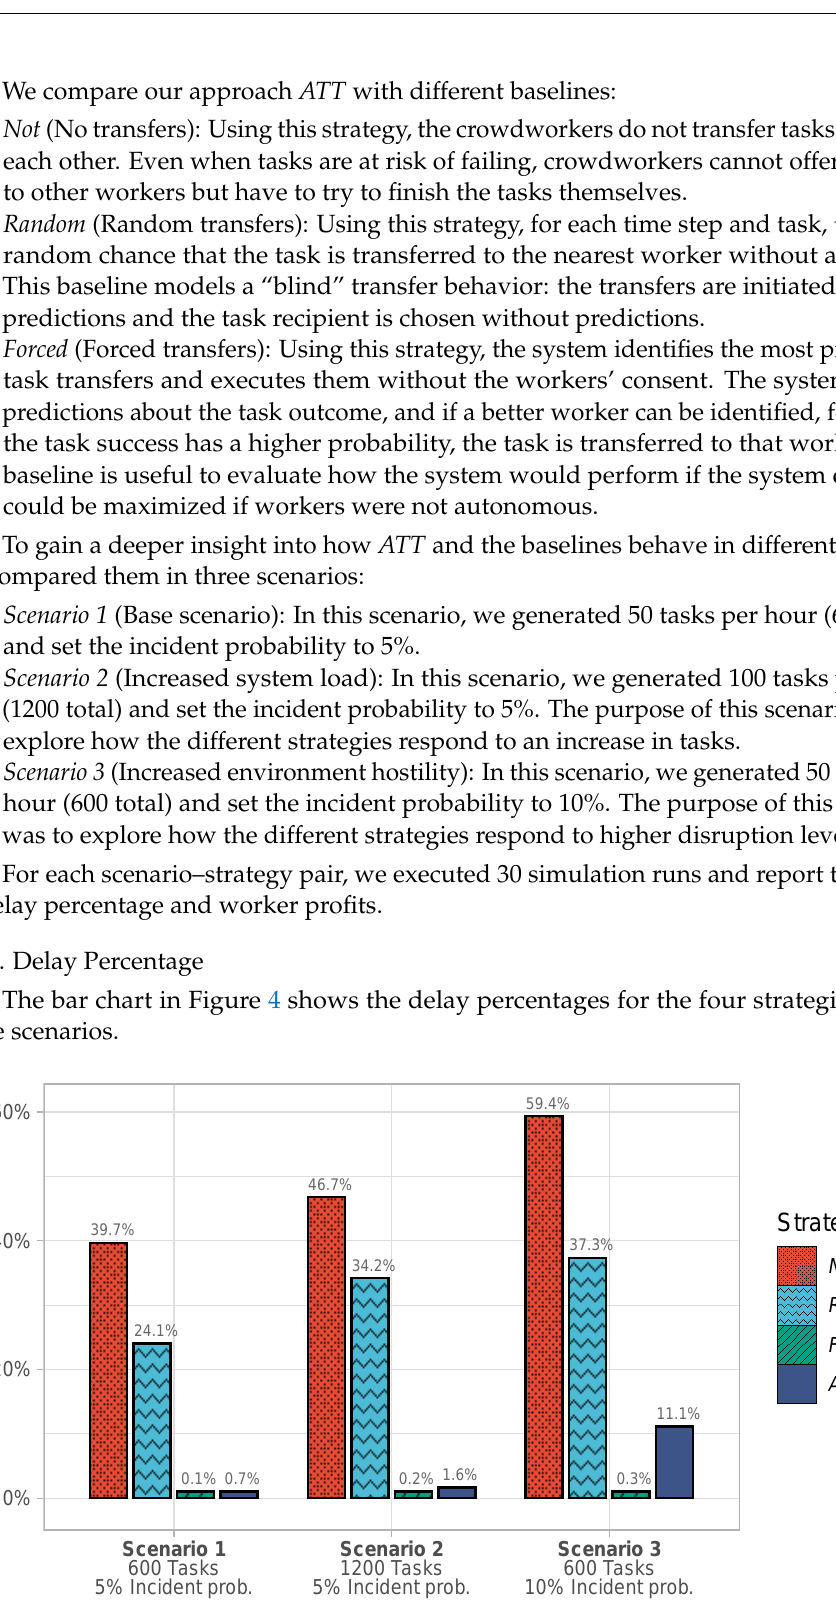
Figure 4. Delays under four strategies in three crowdsensing scenarios. Across the three scenarios, Forced and ATT performed significantly better than Not and Random . Both Not and Random struggled in all scenarios and were affected by higher task counts and incident probabilities. ATT could handle the increase in tasks but started